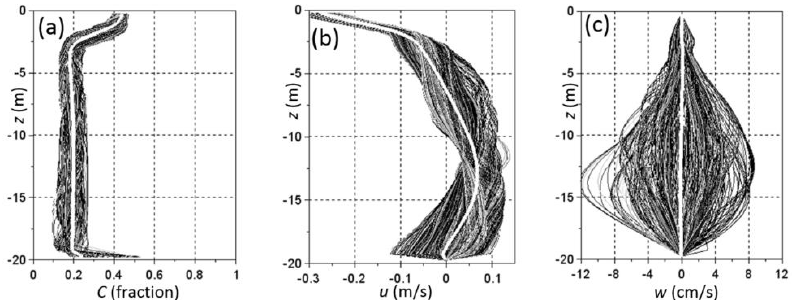
Figure 6. Scenario A ( N = 0) with τ x = −0.1 Pa. The graphs display all vertical profiles within the interval of x = [200 m, 400 m] after 6 h of simulation of ( a ) concentration field C ; ( b ) horizontal velocity u ; and ( c ) vertical velocity w . Thick white lines show horizontally averaged profiles.